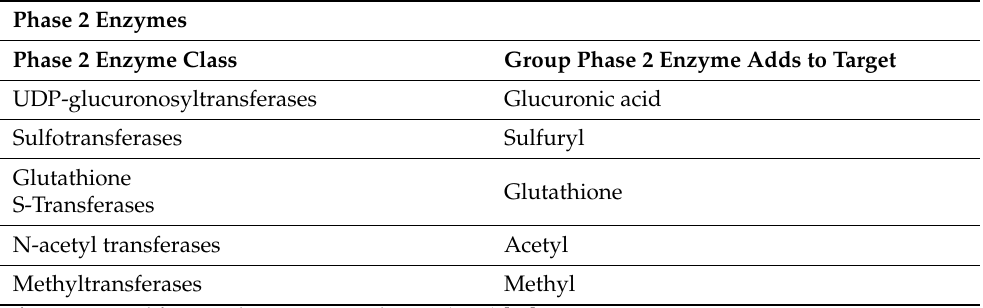
Table 2. Conjugation enzymes that add water-soluble groups to aid in